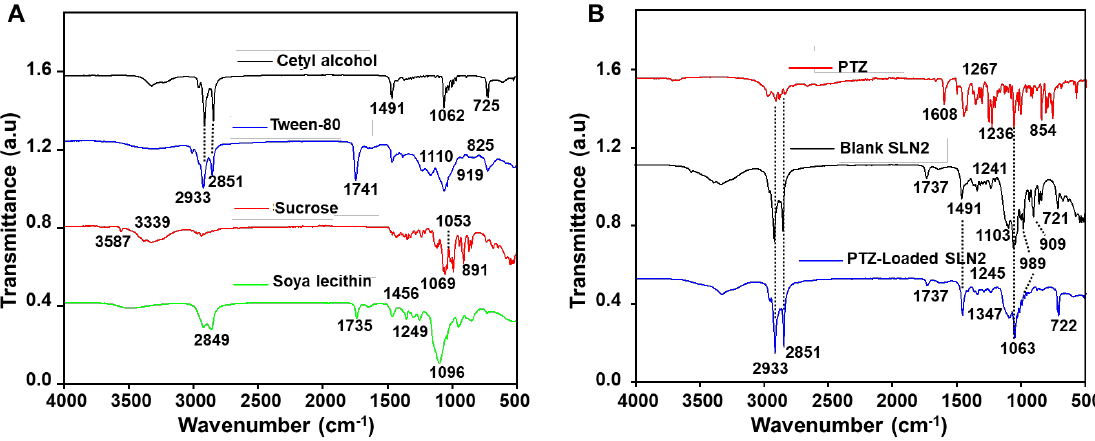
Figure 2. FTIR analysis of ( A ) cetyl alcohol, tween-80, sucrose, and soya lecithine; ( B ) PTZ (drug in